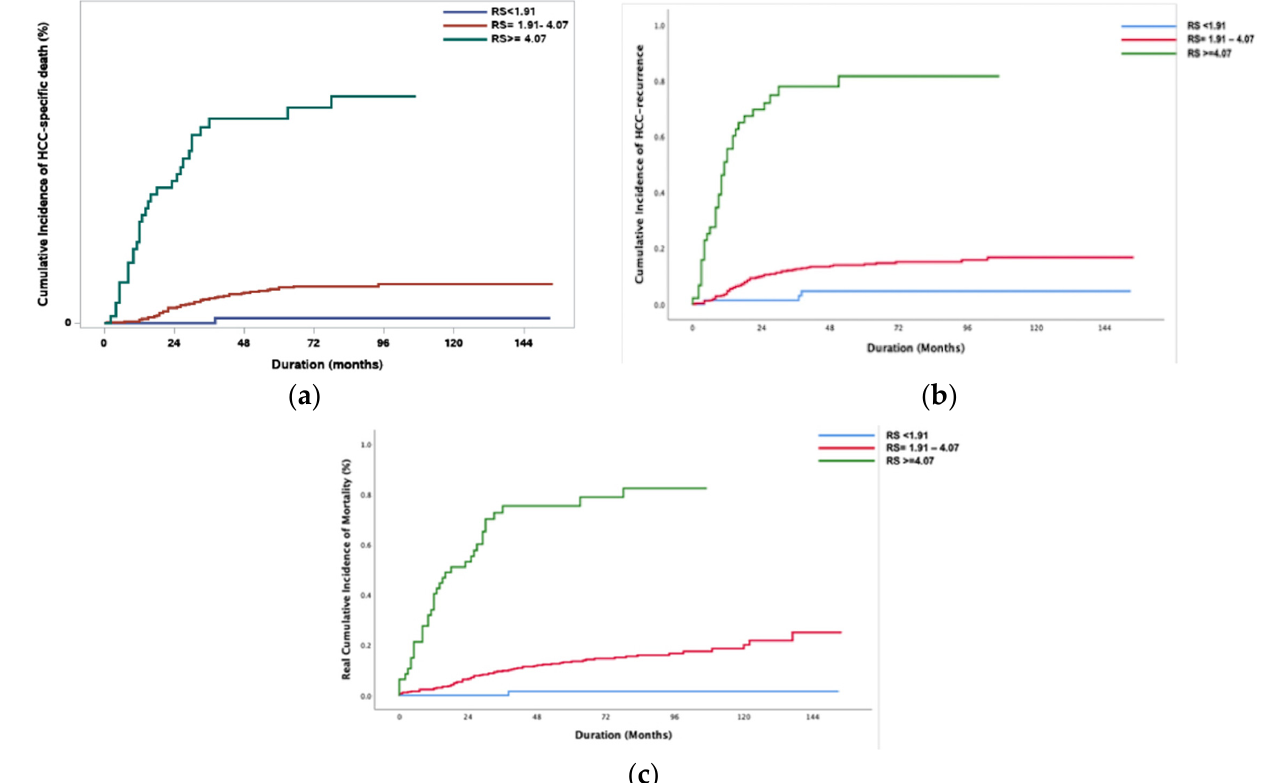
Figure 3. Different incidence rates categorized based on the range of risk scores (RS): ( a ) cumulative incidence rates of HCC-specific death accounting for competing risk of non-cancer-specific death. ( b ) Cumulative incidence of HCC recurrence. ( c ) Real cumulative incidence of mortality in the derivation set according to the risk